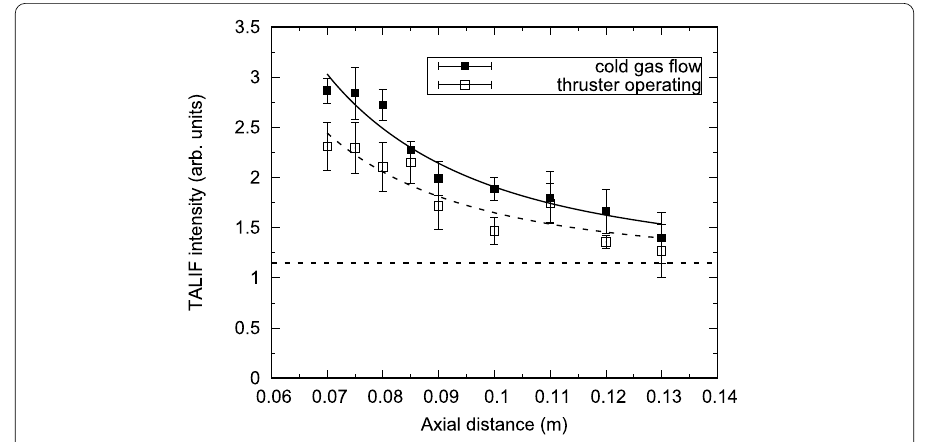
Figure 7 Axial profiles of the krypton neutral densities on the central thruster axis. The distances are given to the accelerator grid on the center